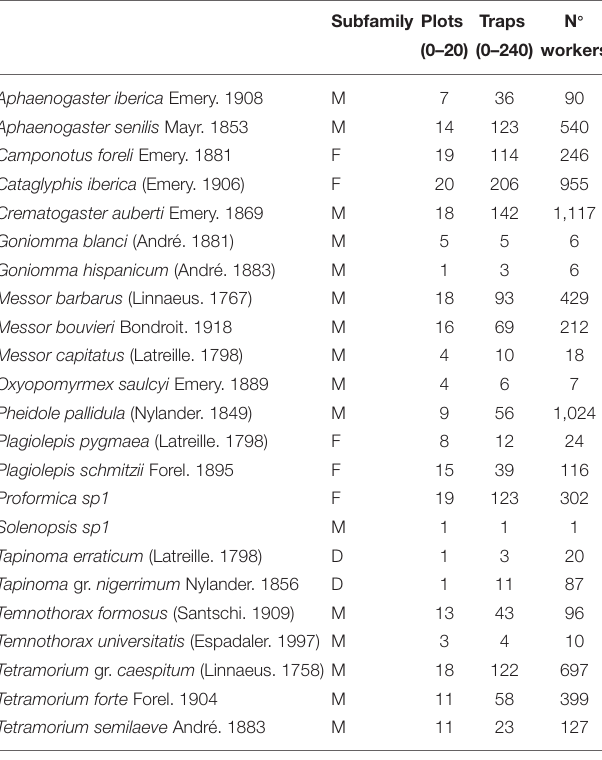
TABLE 2 | Ant species identified in this study, with information on their subfamily, and general data on the frequency & abundance observed in this study. Subfamily Plots